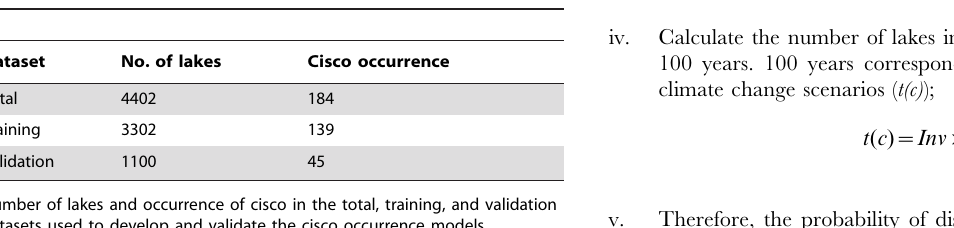
Table 1. Datasets used to develop and validate cisco occurrence